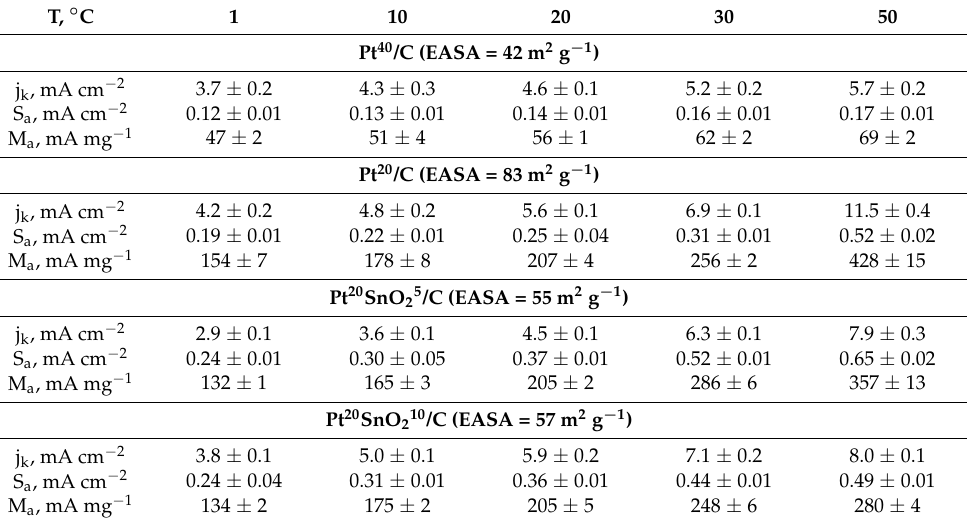
Table 2. Catalyst activity parameters: kinetic current density (j k ), area-specific (S a ) and mass-specific (M a ) activity of catalysts in the temperature range from 1 to 50 ◦ C at potential of 0.9